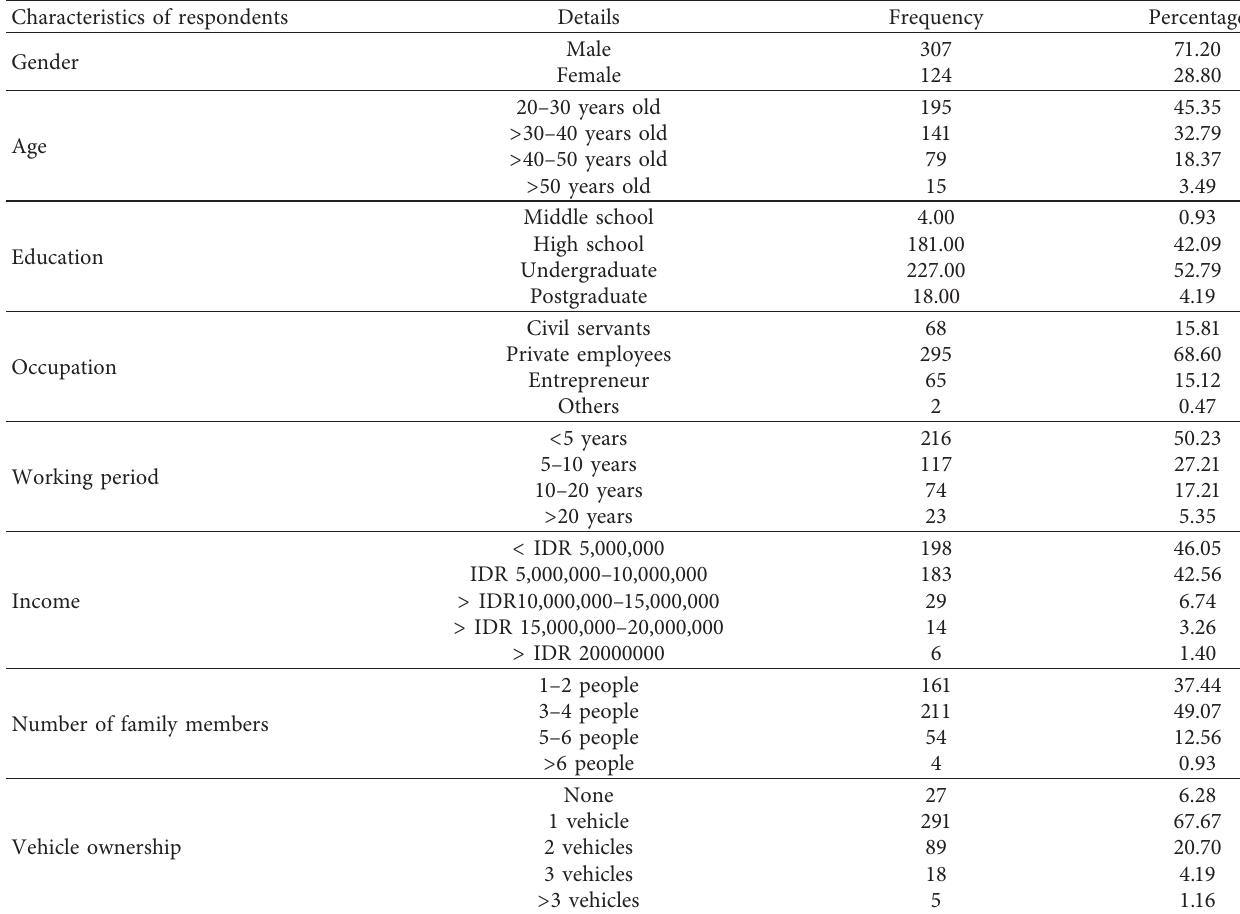
Table 1: Detailed description of respondents’ characteristics.